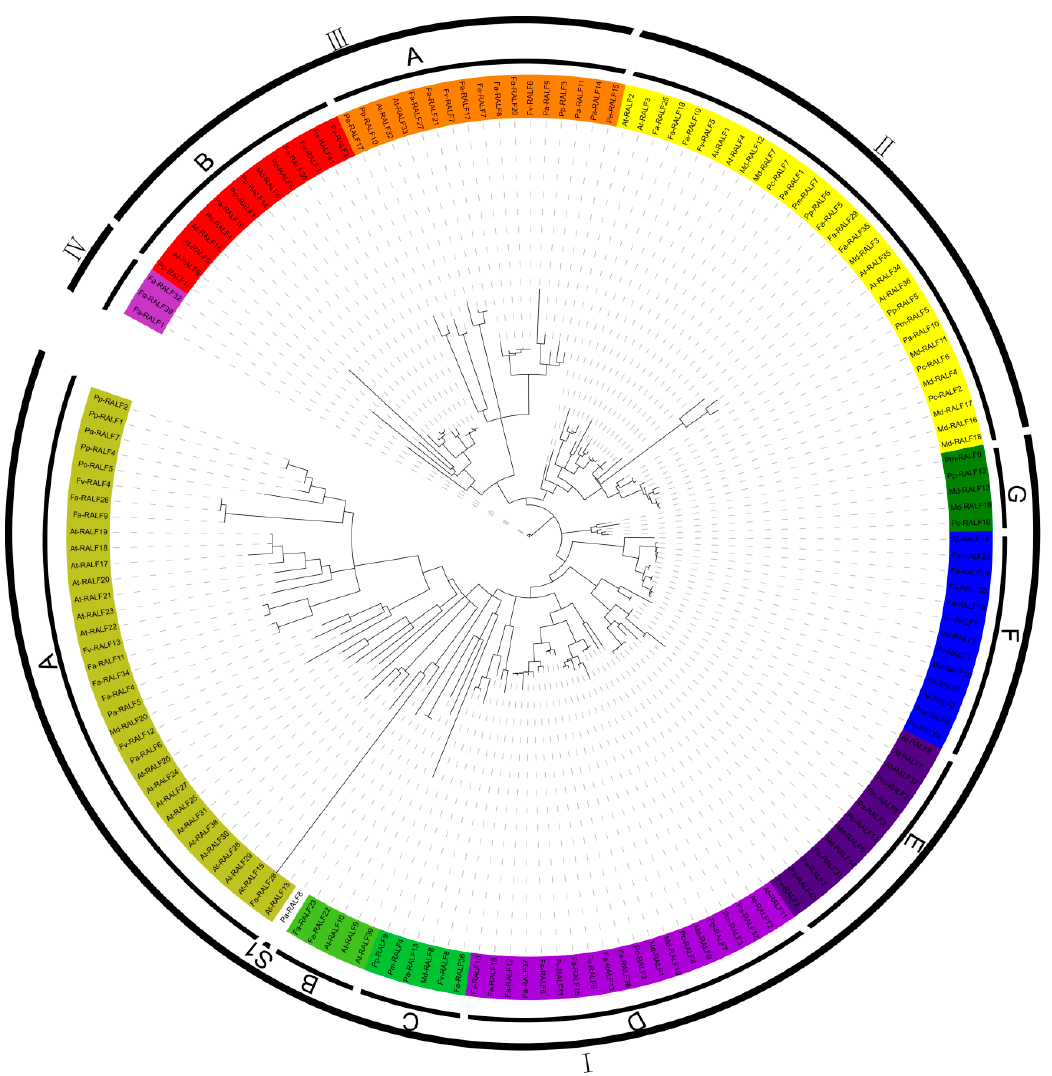
Figure 1. The maximum-likelihood phylogenetic tree of RALF-like proteins among Arabidopsis and seven Rosaceae species.